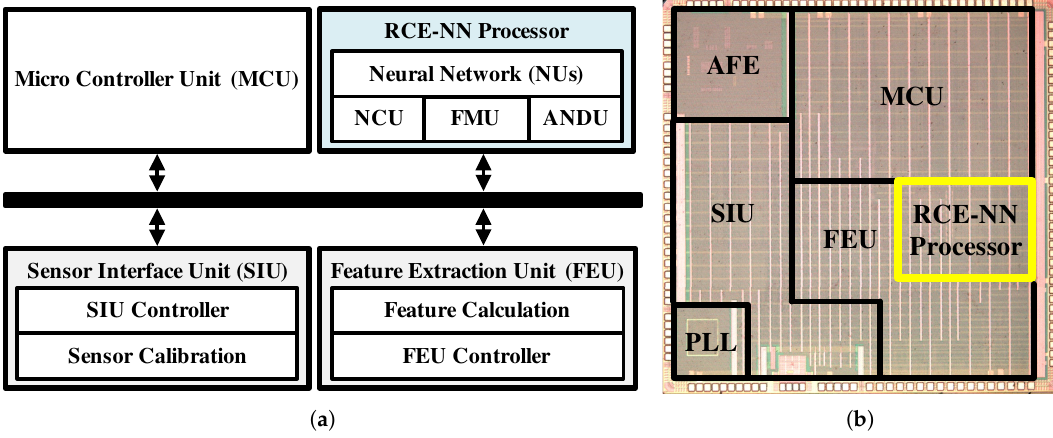
Figure 9. Sensor signal processing system-on-chip (SoC). ( a ) block diagram, ( b ) die